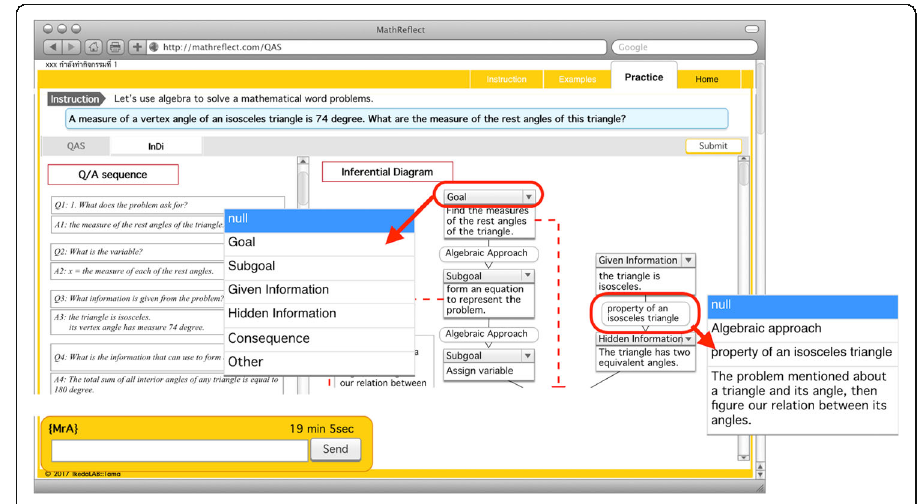
Fig. 8 Web interface of MathReflect at InDi completing